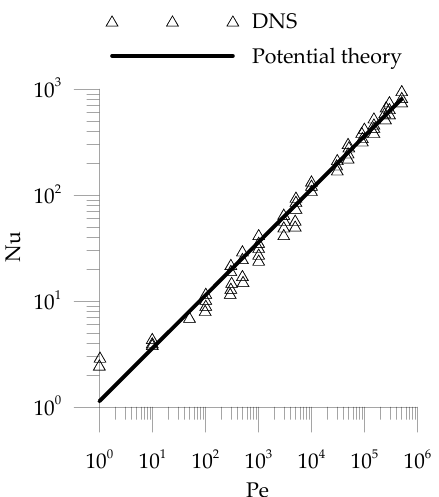
Figure 4. Applicability of the potential theory for calculating average transfer rate around deformed bubbles with wake interaction (DNS data from [35]). DNS: Direct Numerical